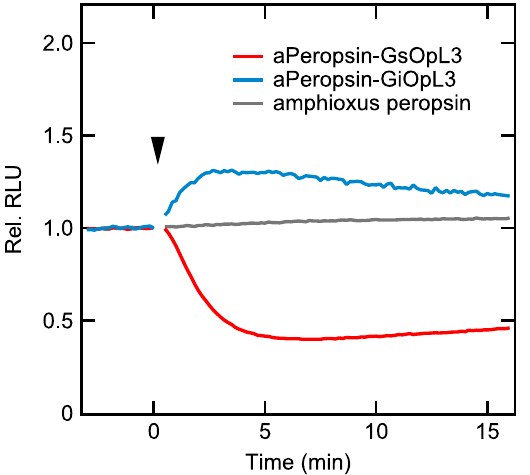
Figure 3. Light-dependent changes in cAMP level in cells expressing amphioxus peropsin and its mutants. GloSensor cAMP assays with cells expressing amphioxus peropsin, aPeropsin-GsOpL3, or aPeropsin-GiOpL3. Cells were illuminated with green light